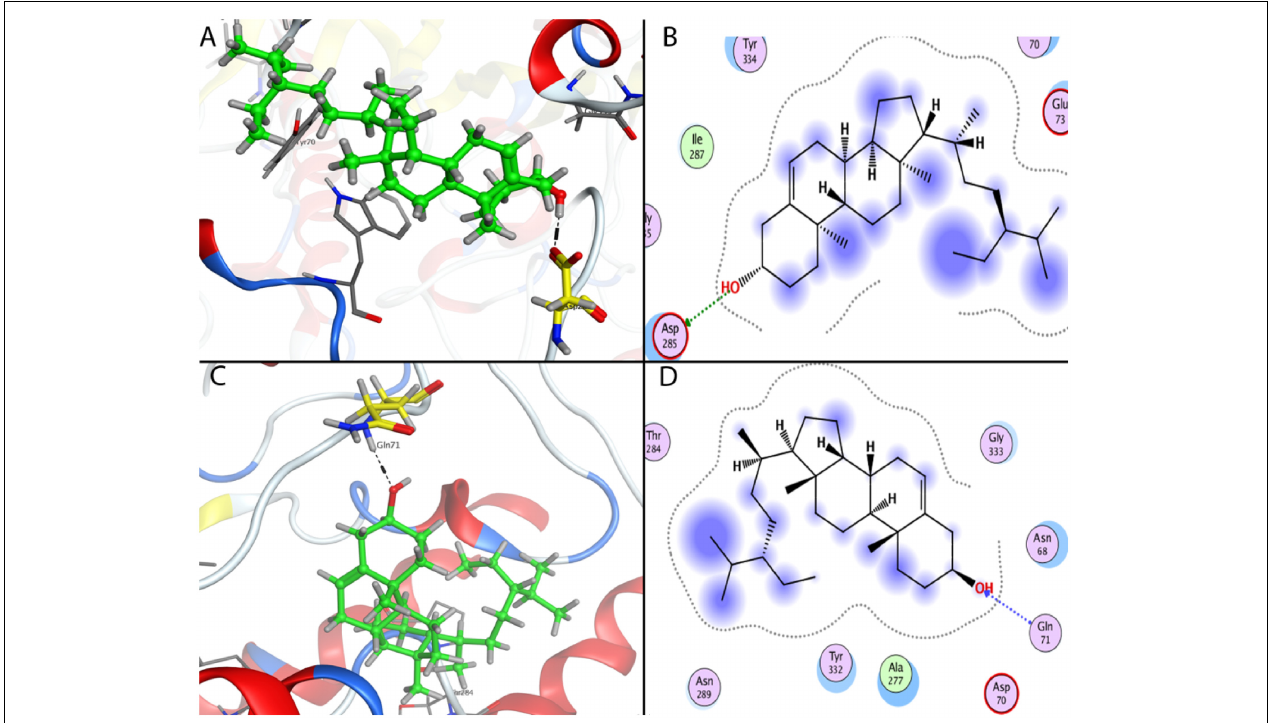
FIGURE 8 | Docking conformations of β -sitosterol on acetylcholinesterase (AChE) and butyrylcholinesterase (BChE). (A) 3D binding mode of β -sitosterol as inhibitor of AChE. (B) 2D binding mode of beta-sitosterol as inhibitor of AChE showing H-donor interaction. (C) 3D binding mode of β -sitosterol in the binding cavity of BChE. (D) 2D binding mode of β -sitosterol as inhibitor of BChE showing H-acceptor